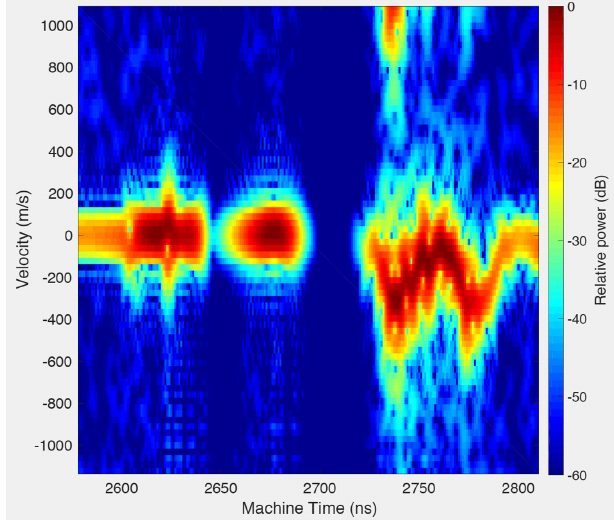
FIG. 8. PDV spectrogram from the D-hole plasma detector deployed on Z3339. First plasma signal occurs at 2600 ns, followed by intermittent signal and complete signal recovery at 2720